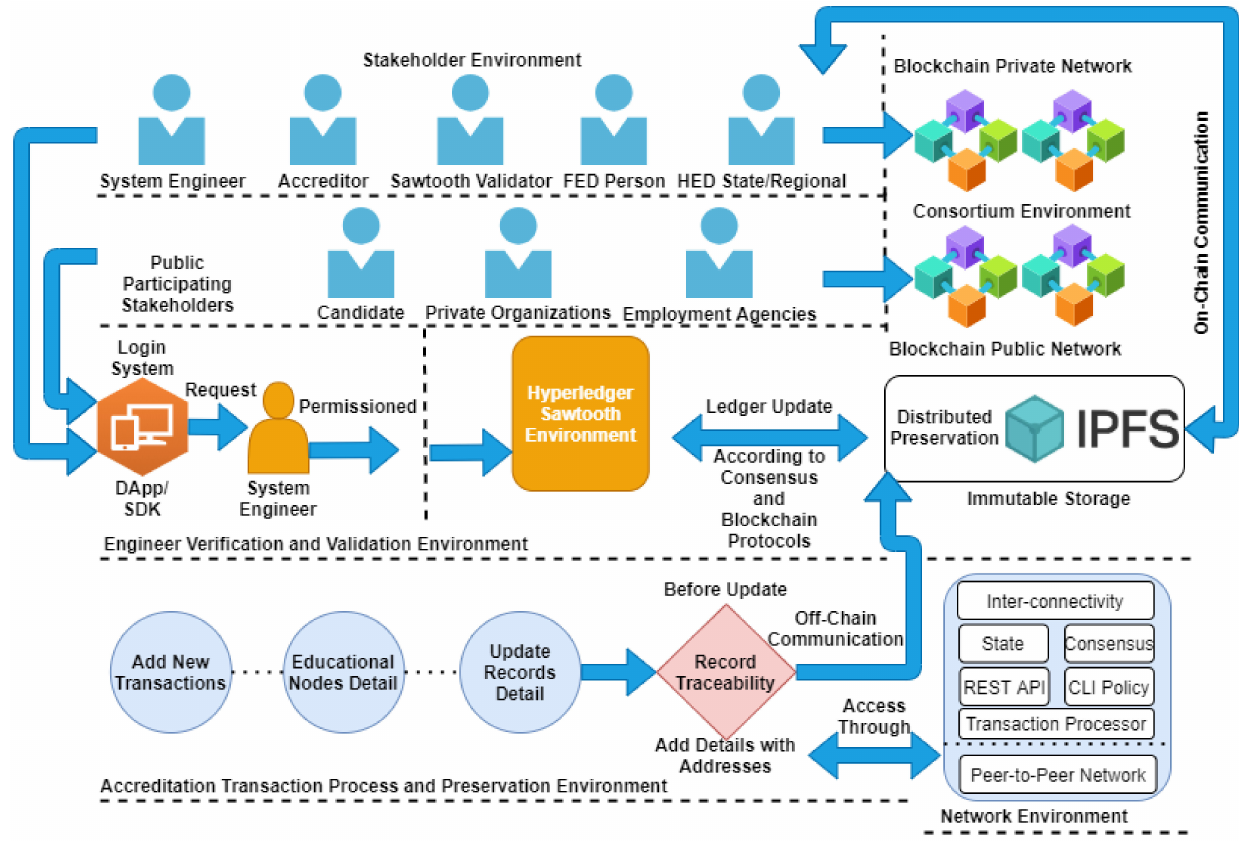
Figure 3. Blockchain hyperledger sawtooth-enabled certificate credentials verification and accredita- tion architecture for